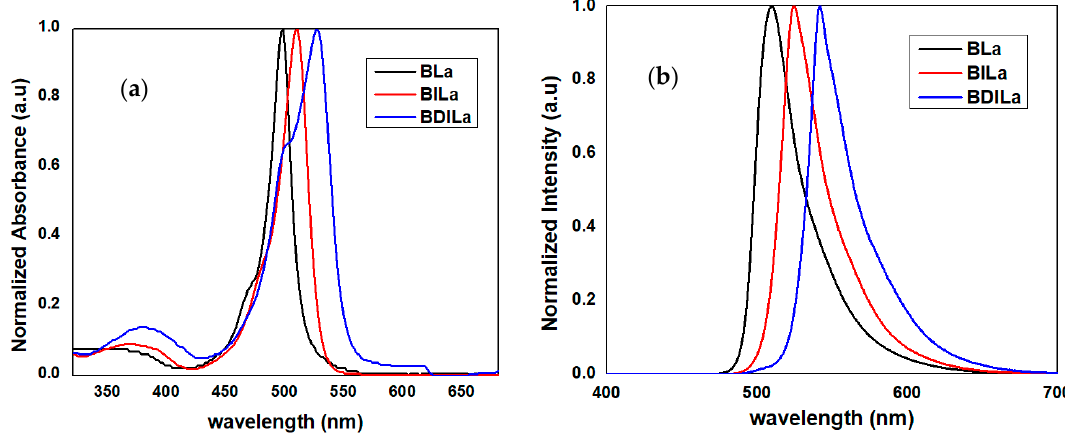
Figure 1. ( a ) absorption and ( b ) emission spectra of the water-soluble BODIPY-based photosensitizers BLa, BILa, and BDILa in aqueous solution. Solutions were excited at their corresponding absorption maxima. Table 1. Photophysical and parameters of the dyes BLa, BILa and BDILa.